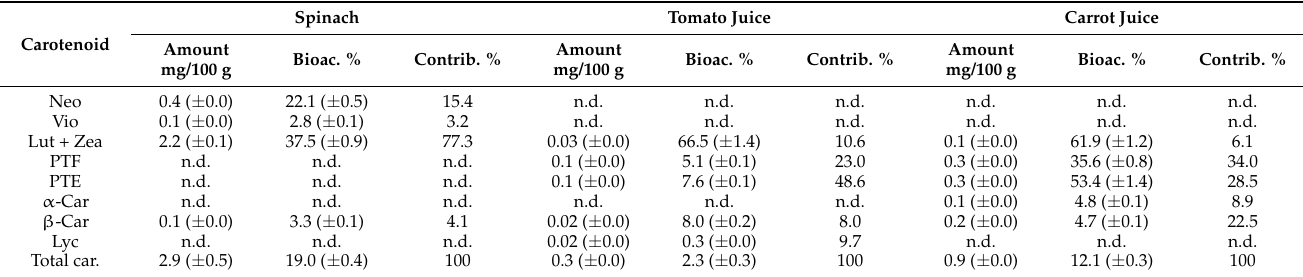
1 Absolute amount of carotenoids after simulated GI digestion of each tested plant food matrices in the obtained bioaccessible fractions. 2 Bioaccessibility expressed as the percentage of carotenoids recovered from the aqueous micellar fraction at the end of the GI digestion, compared to the initial amount present in the undigested test meal. 3 Values represent the contribution (%) of each individual carotenoid, relative to the total amount of carotenoids recovered from the aqueous micellar fraction after the in vitro GI digestion of each matrix. Neo: neoxanthin; Vio: violaxanthin; Lut+Zea: lutein+zeaxanthin; PTF: phytofluene; PTE: phytoene; α -Car: α -carotene; β -Car: β -carotene; Lyc: lycopene. n.d.: not